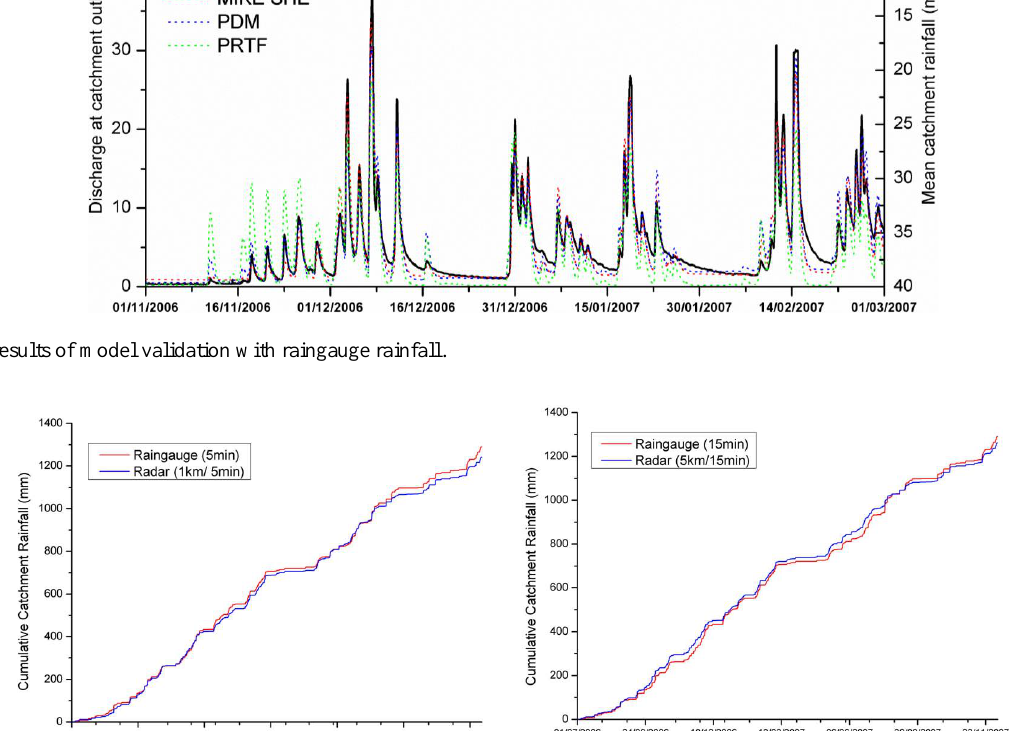
Fig. 4. Comparisons of cumulative catchment rainfall from raingauges and radar at different